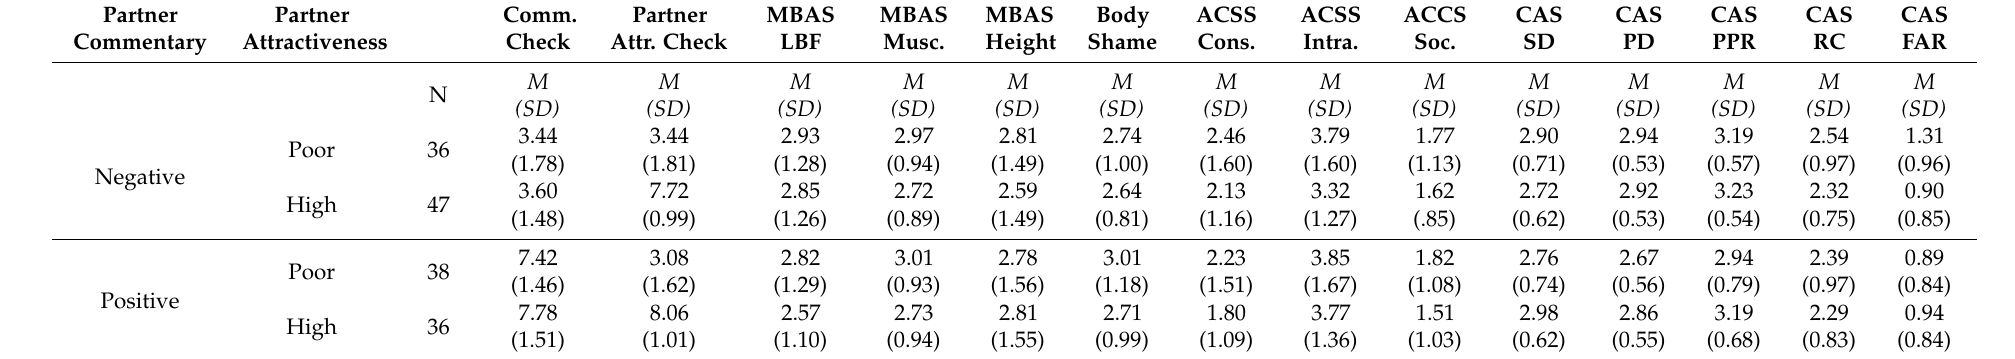
Table 1. Means (SDs) of body dissatisfaction, acceptance of cosmetic surgery, and quality of couple’s relationship by experimental condition (men).